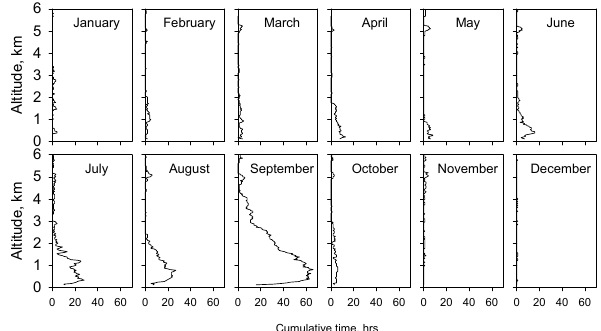
Fig. 10. Seasonal and vertical features of cumulative time of MPL data with aerosol backscatter ratio higher than 1.55 and standard deviation lower than 0.1 in 2012 over Syowa Station,